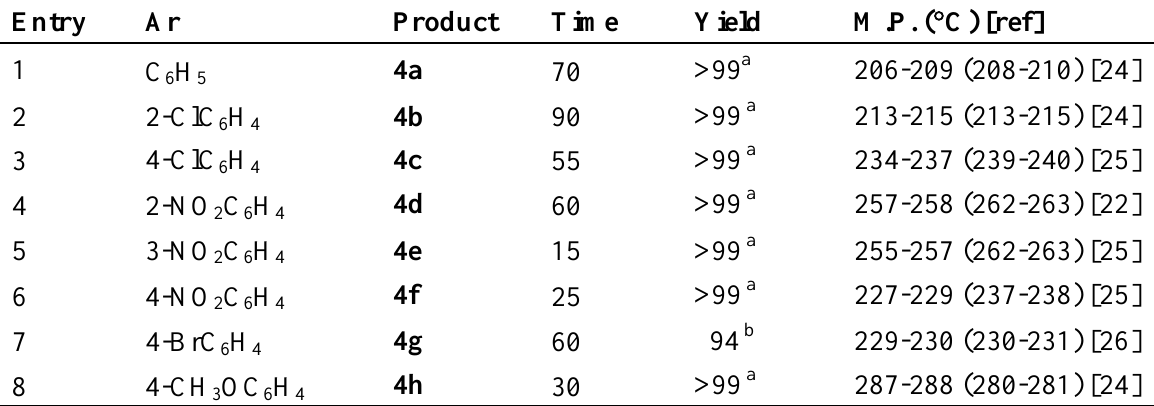
Table 1. Synthesis of pyrano [2,3-d] pyrimidine-2,4(1 H ,3 H )-diones under solvent-free and catalyst-free